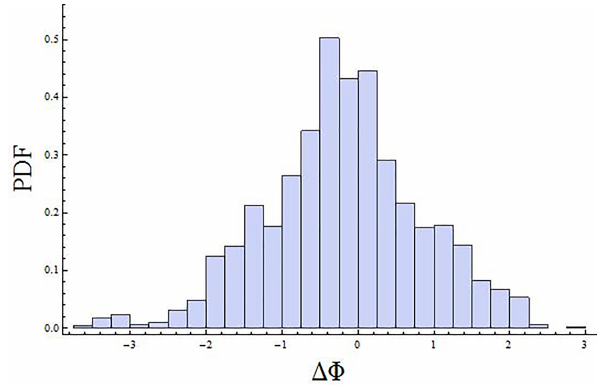
longitude increase from west to east, as in Marx (2012a)